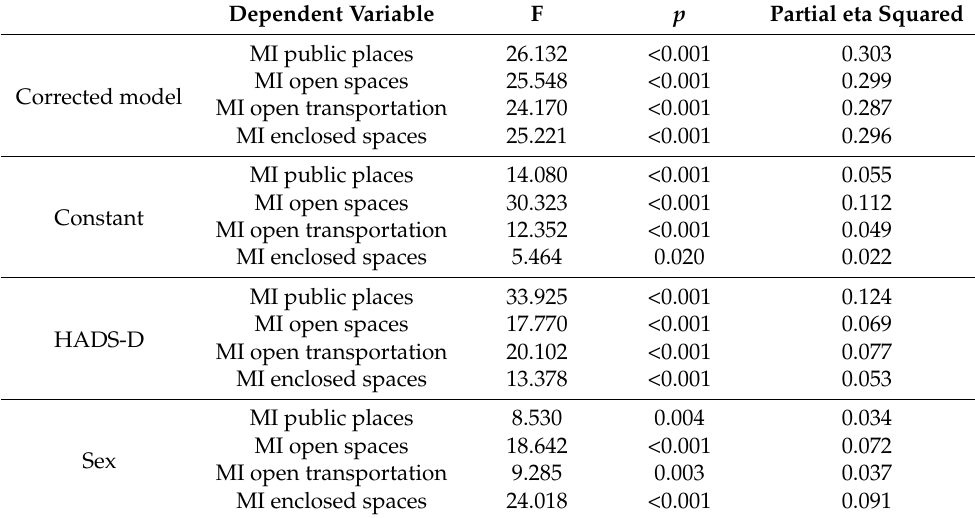
Table 4. Post-hoc univariate ANOVAs.